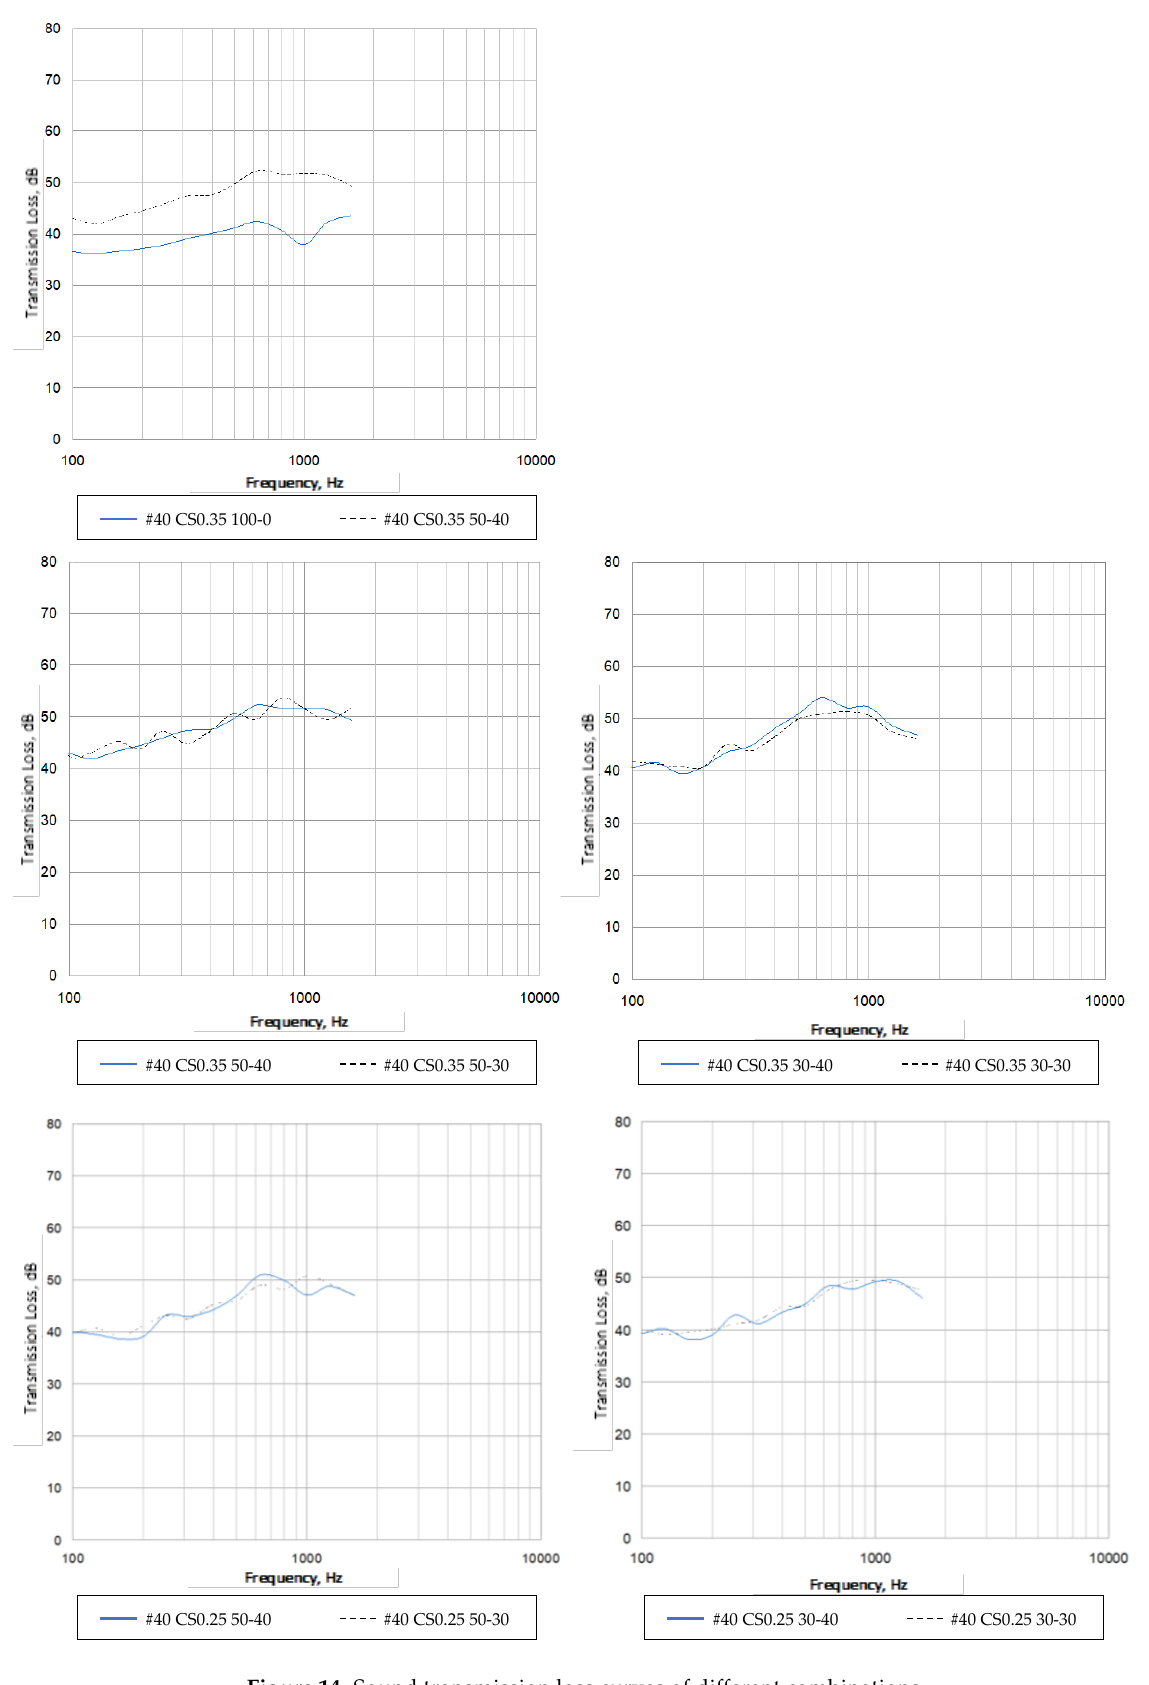
Figure 14. Sound transmission loss curves of different combinations.